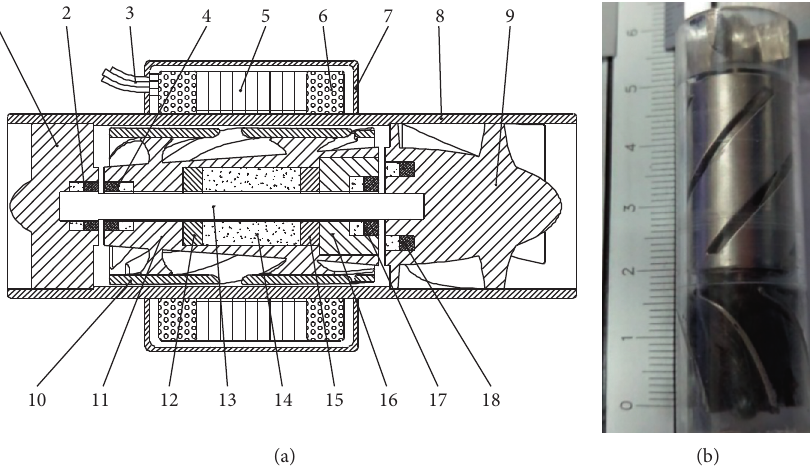
Figure 1: (a) Schematic of the MHDL axial blood pump: (1) front guide vane; (2) PM ring I-1; (3) conductor; (4) PM ring I-2; (5) stator core; (6) coil winding; (7) notor housing; (8) pump housing; (9) rear guide vane; (10) HD shell; (11) impeller; (12) magnetic isolation ring I; (13) shaft; (14) PM of the rotor; (15) magnetic isolation ring II; (16) end cap; (17) PM ring II-1; (18) PM ring II-2. (b) The prototype of the blood pump.